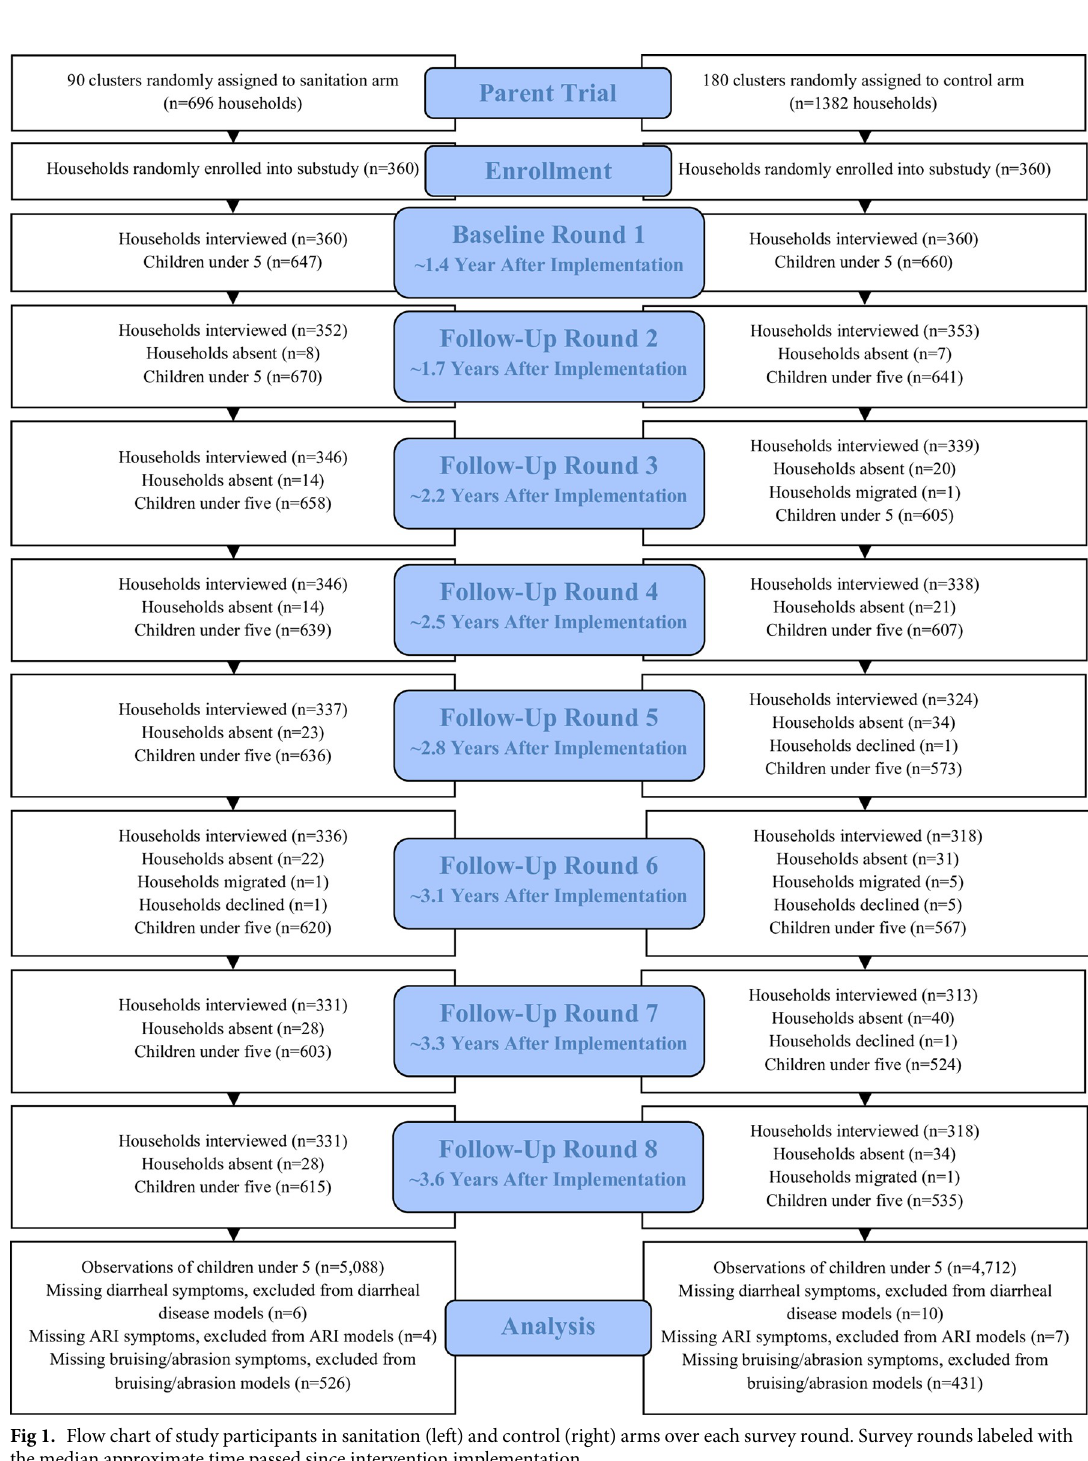
Fig 1. Flow chart of study participants in sanitation (left) and control (right) arms over each survey round. Survey rounds labeled with the median approximate time passed since intervention implementation.